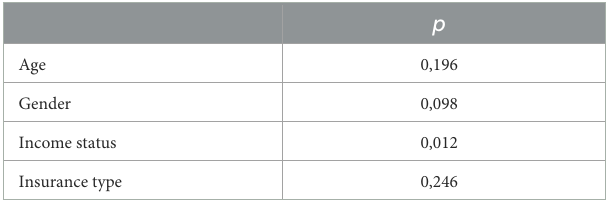
TABLE 5 The relationship between age, gender, income status and insurance type and out-of-pocket health